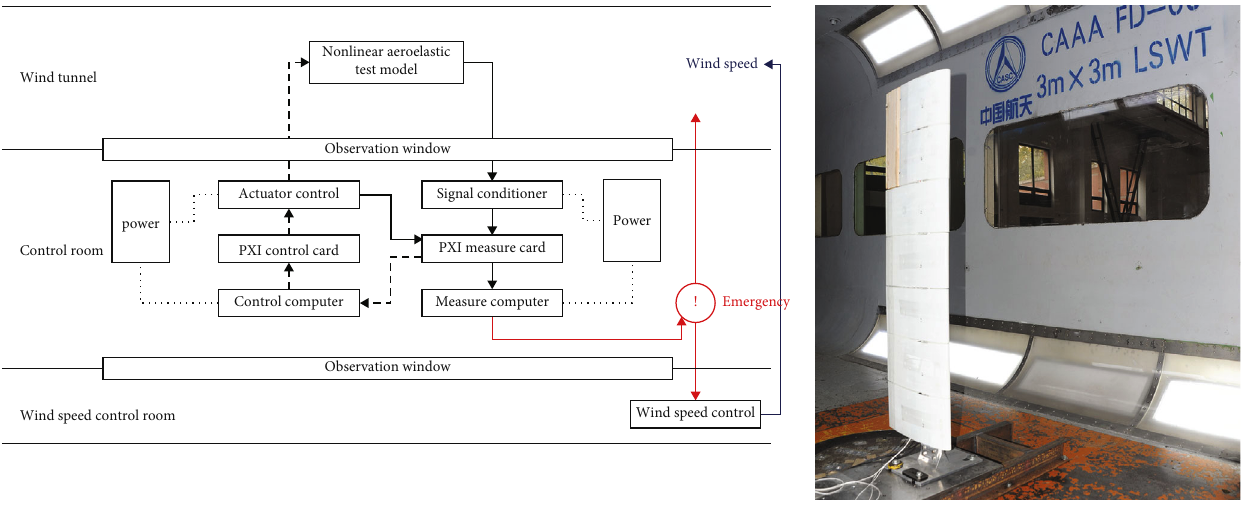
Figure 15: Experimental setup of linear and nonlinear wind tunnel fl utter tests.